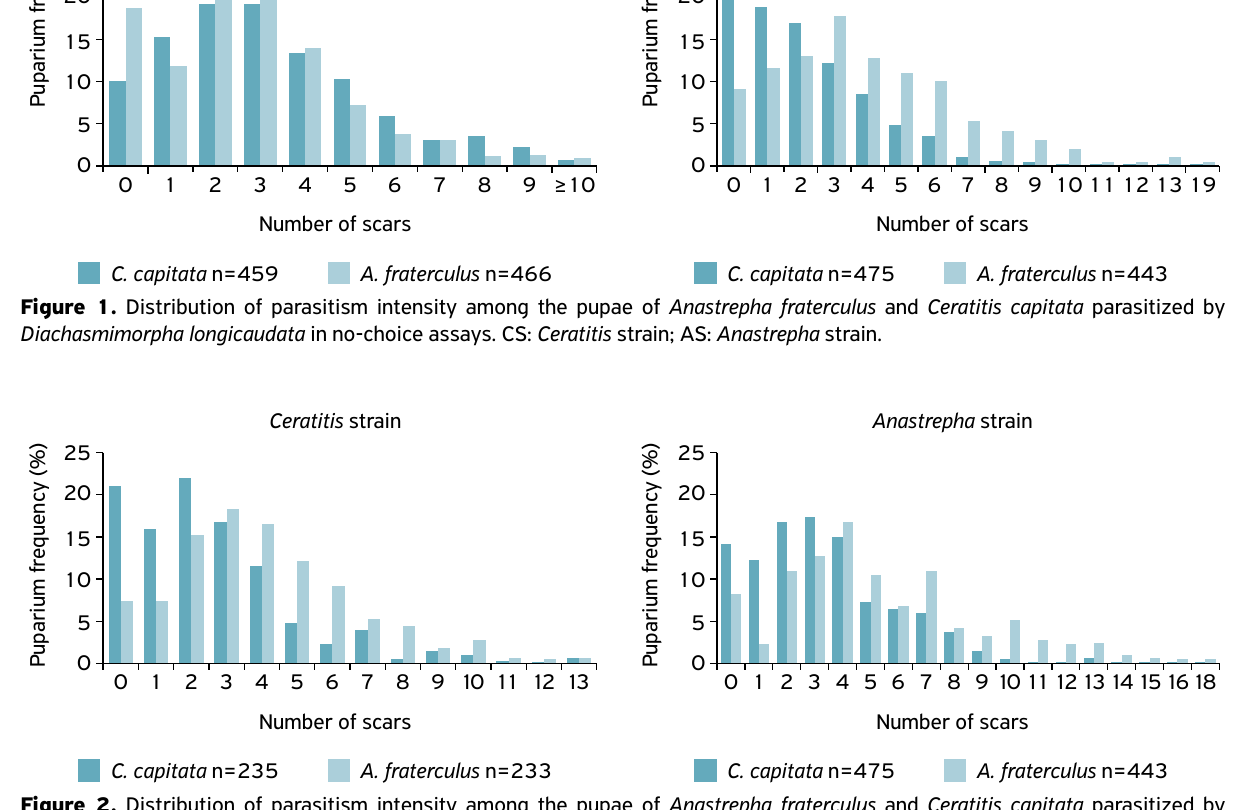
Figure 2. Distribution of parasitism intensity among the pupae of Anastrepha fraterculus and Ceratitis capitata parasitized by Diachasmimorpha longicaudata in free‑choice assays. CS: Ceratitis strain; AS: Anastrepha